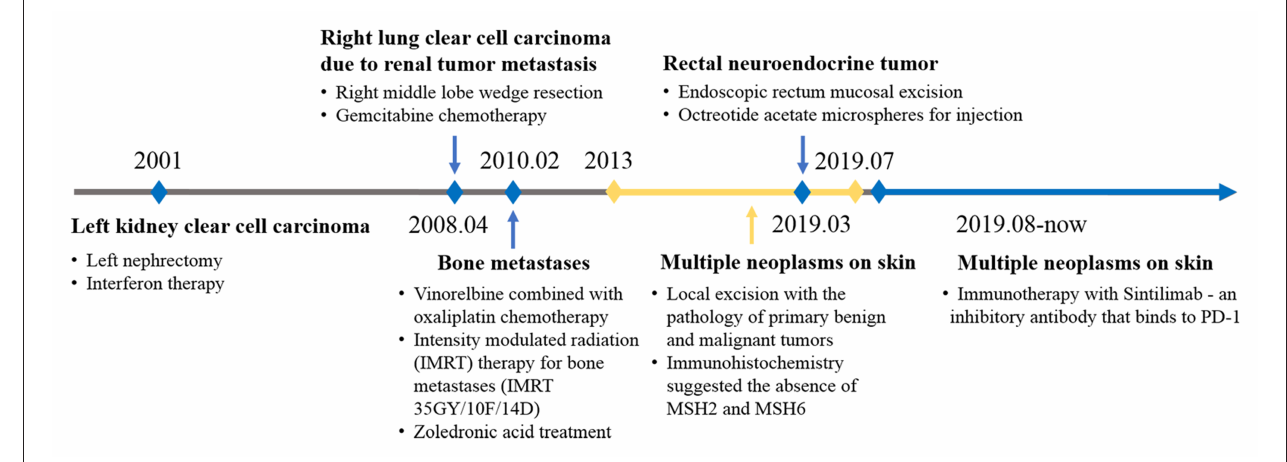
FIGURE 1 | Timeline of disease diagnosis and